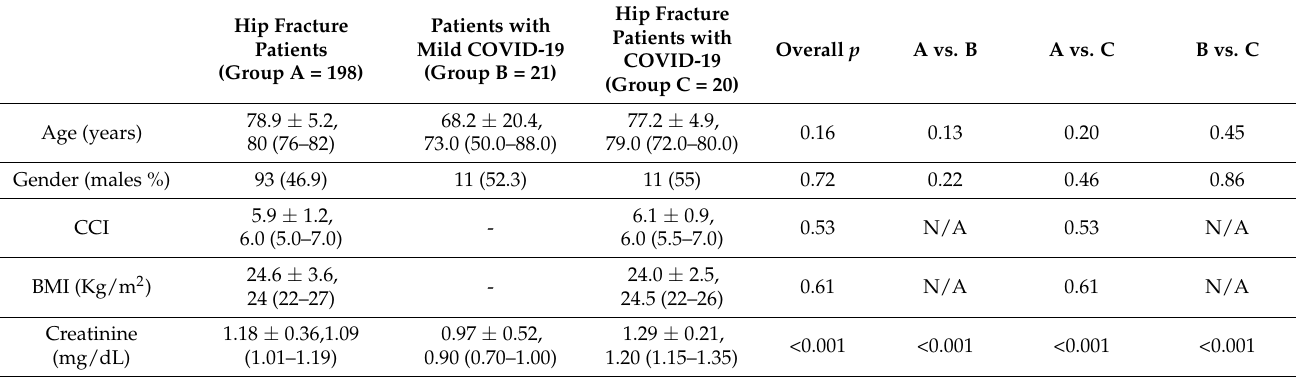
Table 1. Characteristics of the study